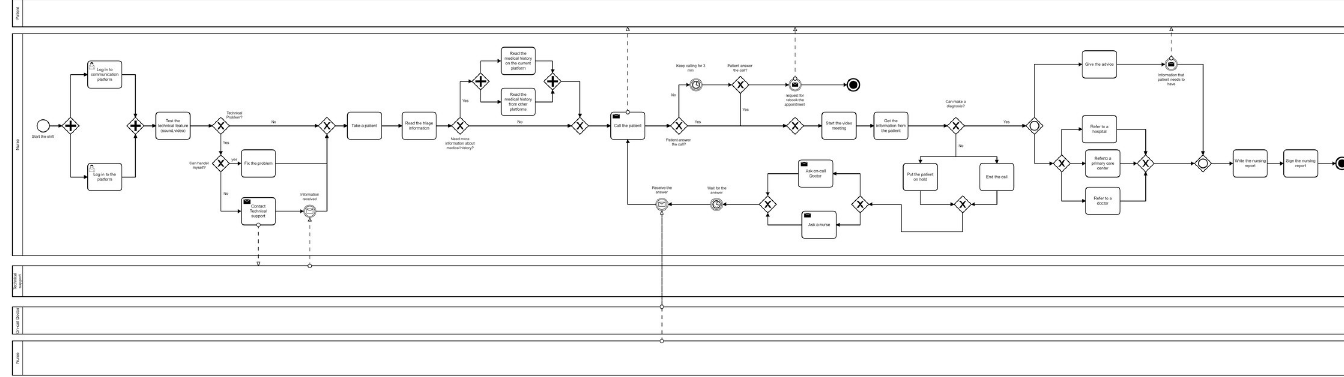
Fig 1. Nurses’ work process